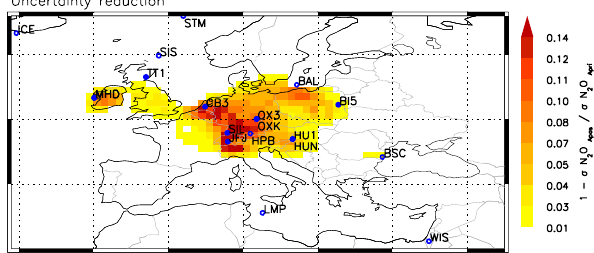
Fig. 4. Calculated reduction of uncertainties of emissions per grid /σ N ). Allowed values are in the interval cell (1 − σ N 2 O apri 2 O apos [ 0 , 1 ] , 0 indicating that the a posteriori uncertainty is equal to the a priori uncertainty (no reduction), 1 indicating a perfect uncertainty